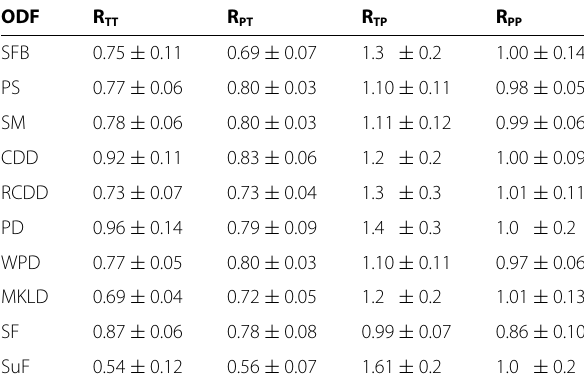
Table 4 R TC figures for the different onset detectors considered. R xy represents each R TC score, where x refers to the selection function (OSF) used and y to the interactive approach